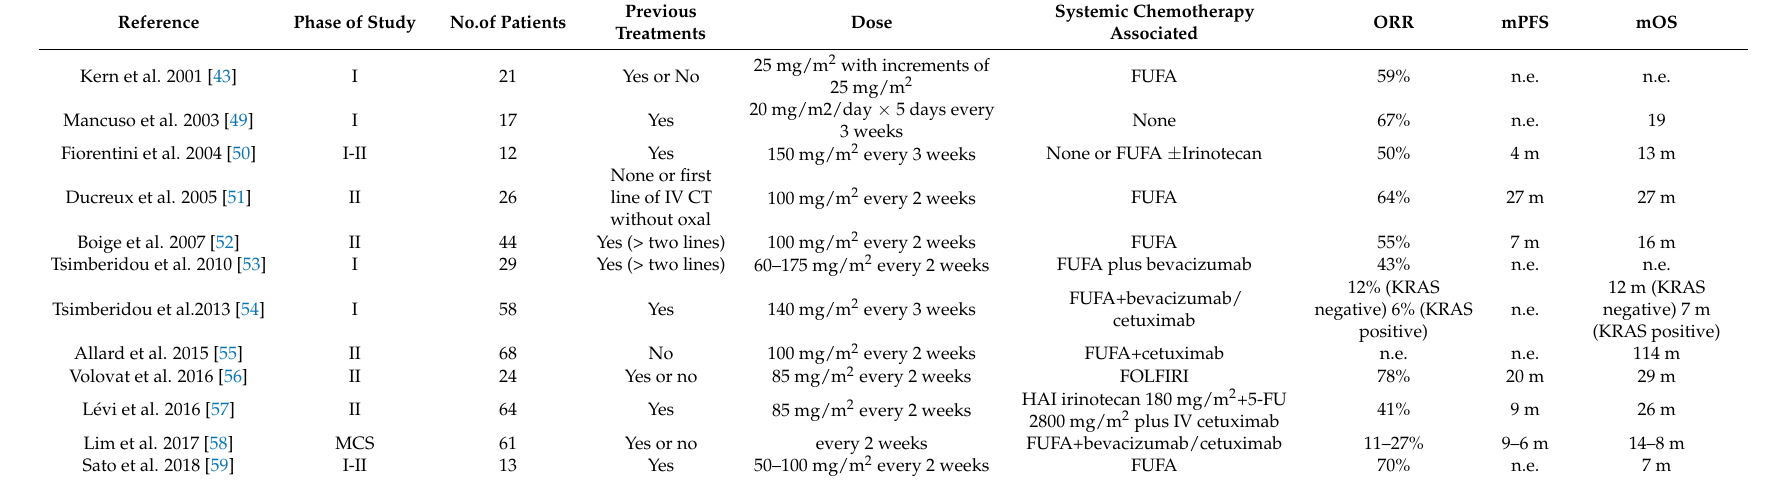
Table 2. Clinical trials that evaluated HAI oxaliplatin in patients with unresectable liver metastases from colo-rectal